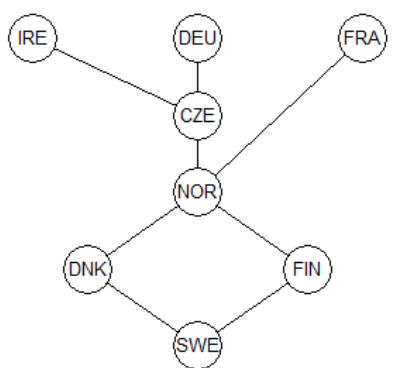
Figure 4. Hasse diagram applied after the application of operator G (Table 5) on the original MIS (Table